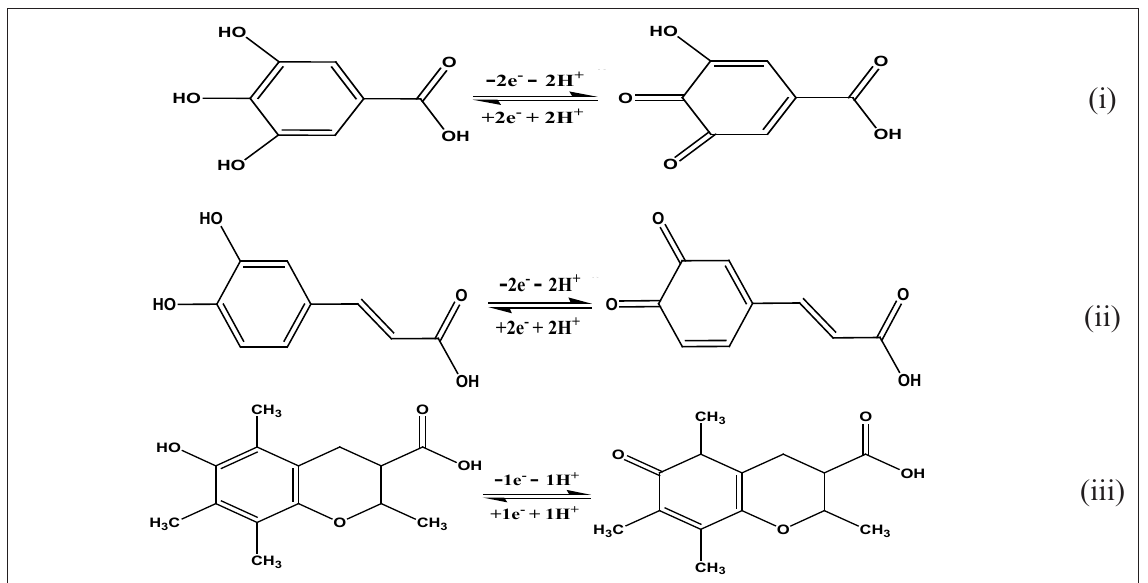
Scheme 1. Electrochemical oxidations of gallic acid (i), caffeic acid (ii) and trolox (iii) on a carbon paste electrode